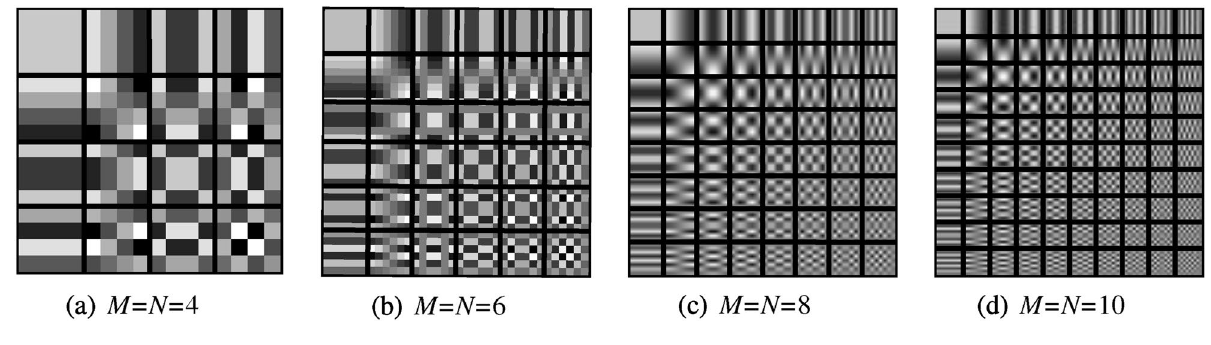
Figure 3. DCT base